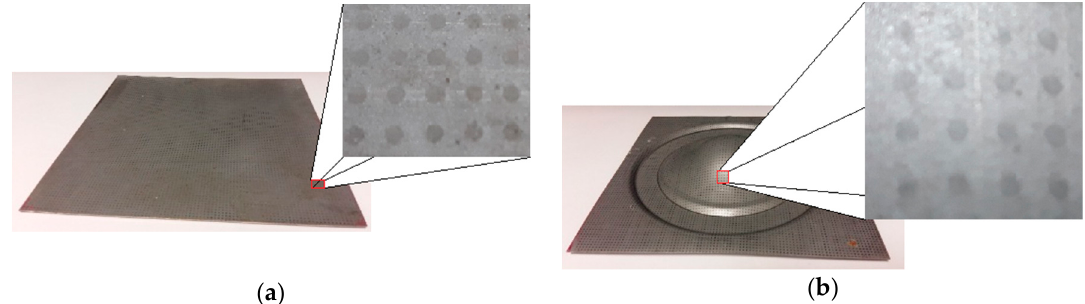
Figure 2. ( a ) Circles on metal sheet without deformation; and ( b ) circles on formed metal sheet.